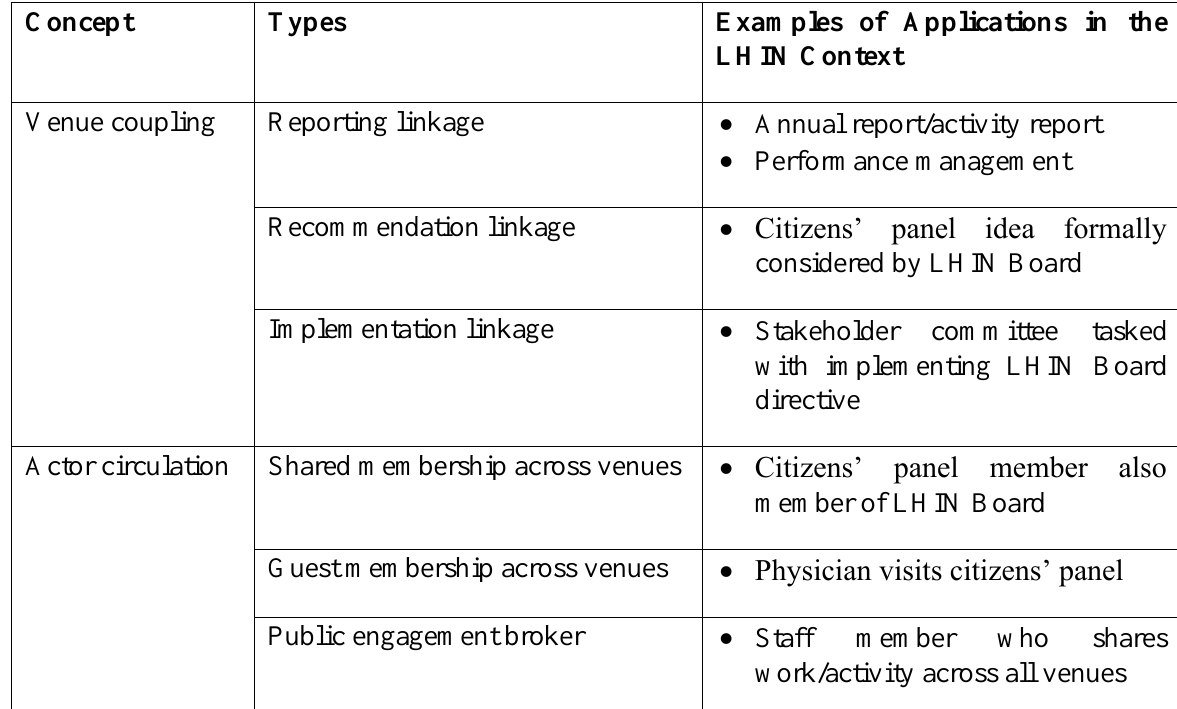
Operationalizing Venue Coupling and Actor